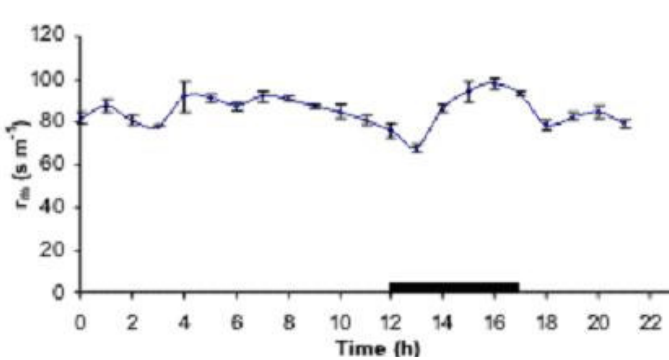
FIGURE 1. Mesophyll resistance (r m ), 24-h profile. Vertical bars indicate ± SE. Horizontal thick bar indicates the period of maximum values of ozone. Time is set from 0 to 23 h. n = 24.